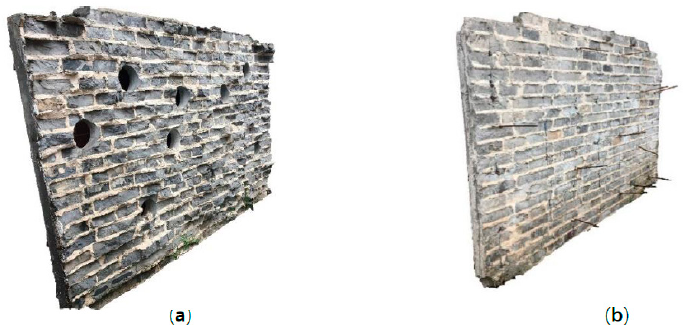
Figure 14. The interface between the strengthening layers and the masonry substrate: ( a ) The coarse interface between the UHPC layer and the masonry substrate; ( b ) The smooth interface between the reinforced polymer mortar layer and the masonry substrate.